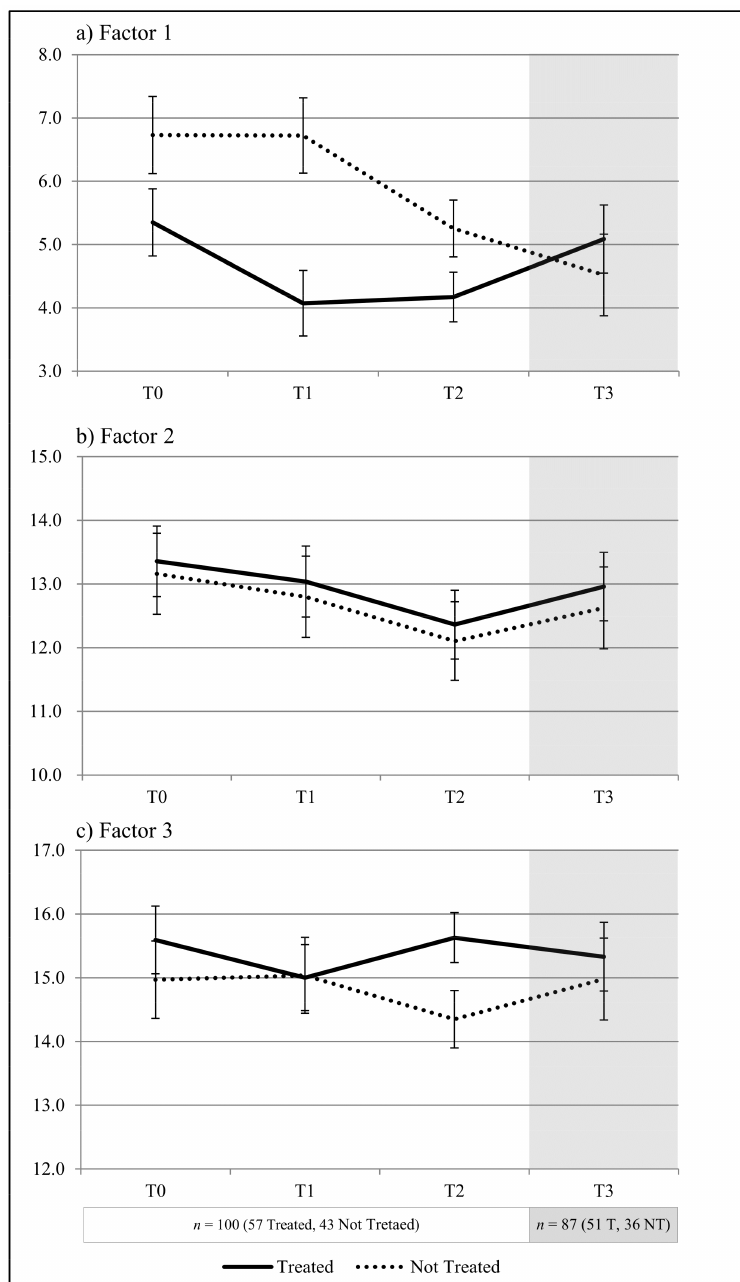
Figure 1. Least square means by time and treatment of scores for factors of questionnaire C. ( a ) Factor 1 “ foods that are not good for your health ”; ( b ) Factor 2 “ foods good for your health ”; ( c ) Factor 3 “ foods that are very good for your health